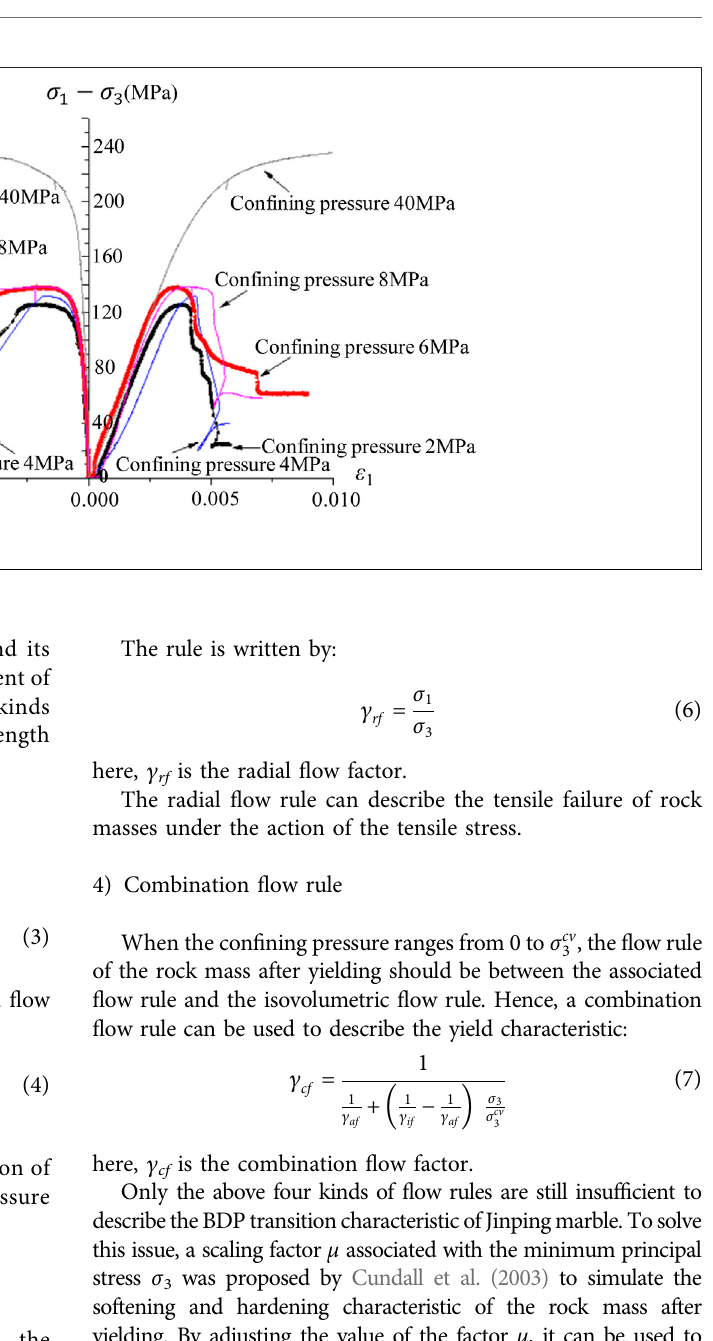
Table 3 . As for the determination of scaling factor μ , in this paper,